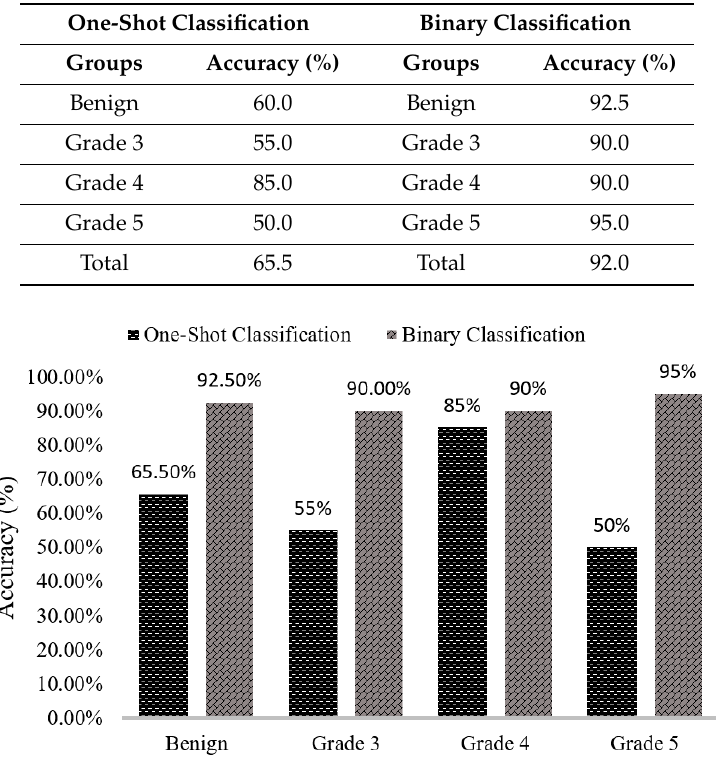
grade groups. In the case of one-shot classification, the classifier could not accurately distinguish among the four groups. In the case of binary classification, the classifier was almost always accurate, with little variation. Table 8. Multilayer perception (MLP) classifier, comparison between one-shot and binary classification.